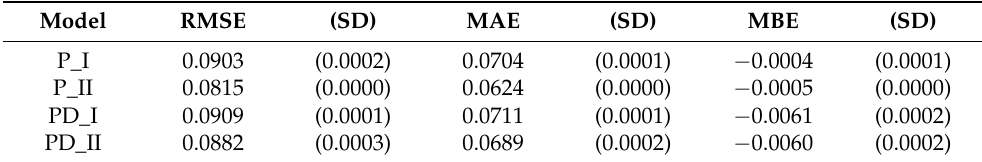
Figure 10. Observed versus fitted values of friction for the models. The line is a 1:1 line. Table 12. The Root Mean Square Error (RMSE), the Mean Absolute Error (MAE), the Mean Bias Error (MBE), and the respective standard deviation for each